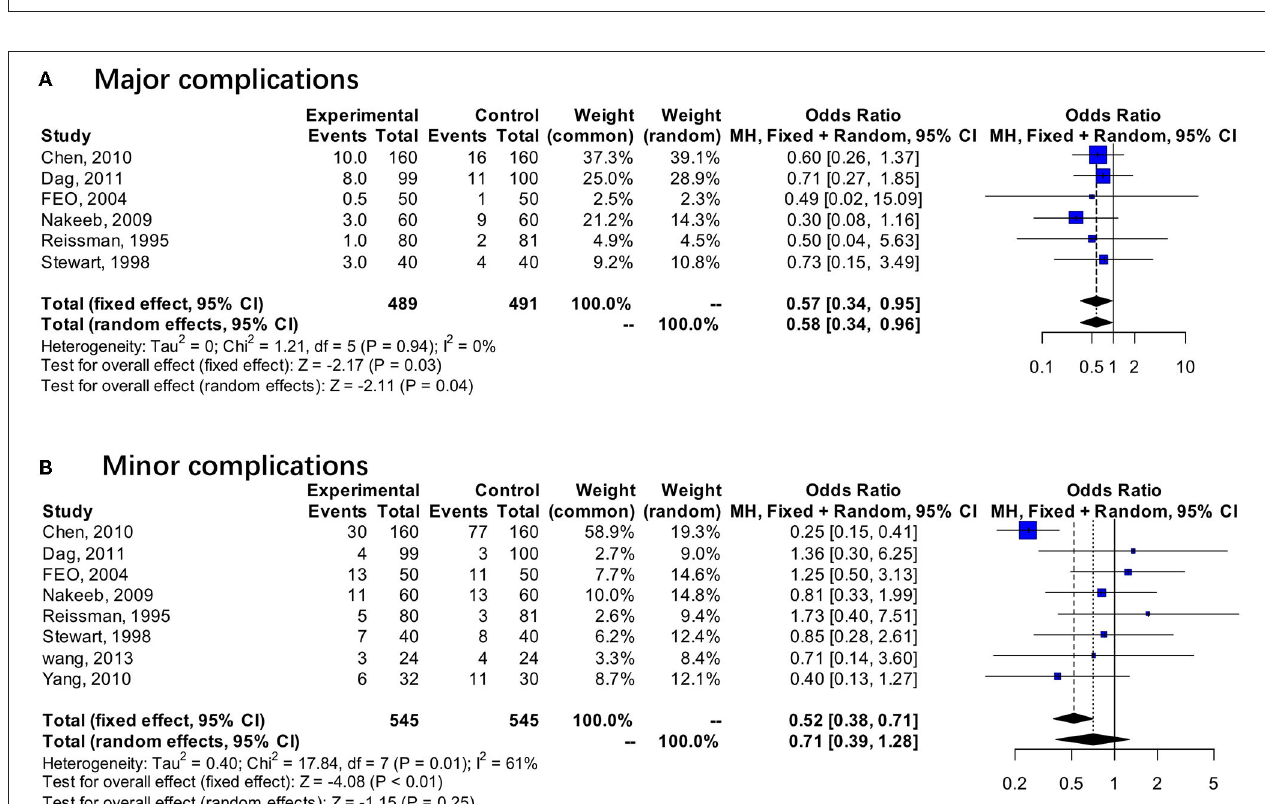
FIGURE 6 | Forest plots of total complications. (A) Major complications. (B) Minor